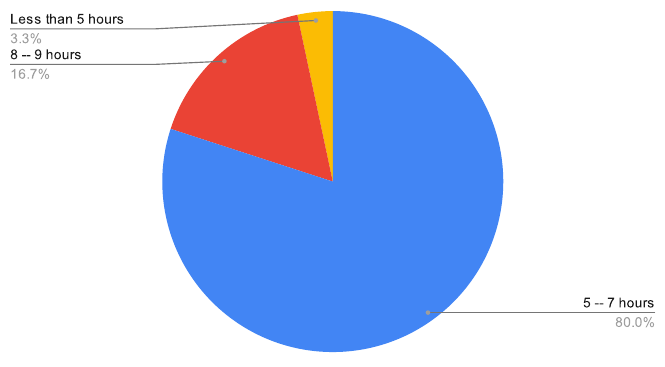
Figure 4. Time of Sleep Before Experiment.